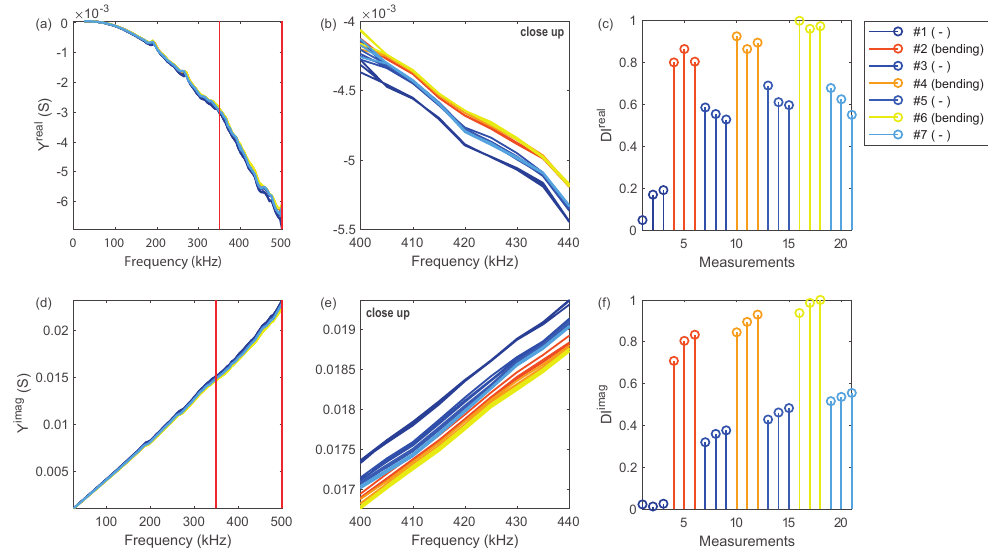
Figure 7. EMI analysis for transducer T 3 : ( a ) real part of the admittance; ( b ) real part of the admittance (close up); ( c ) DI real for different loading conditions; ( d ) imaginary part of the admittance; ( e ) imaginary part of the admittance (close up); ( f ) DI imag for different loading conditions. All DIs were calculated for the frequency band of 350–500kHz showing a slightly improved contrast between intact and damaged structure compared to the full frequency spectrum.